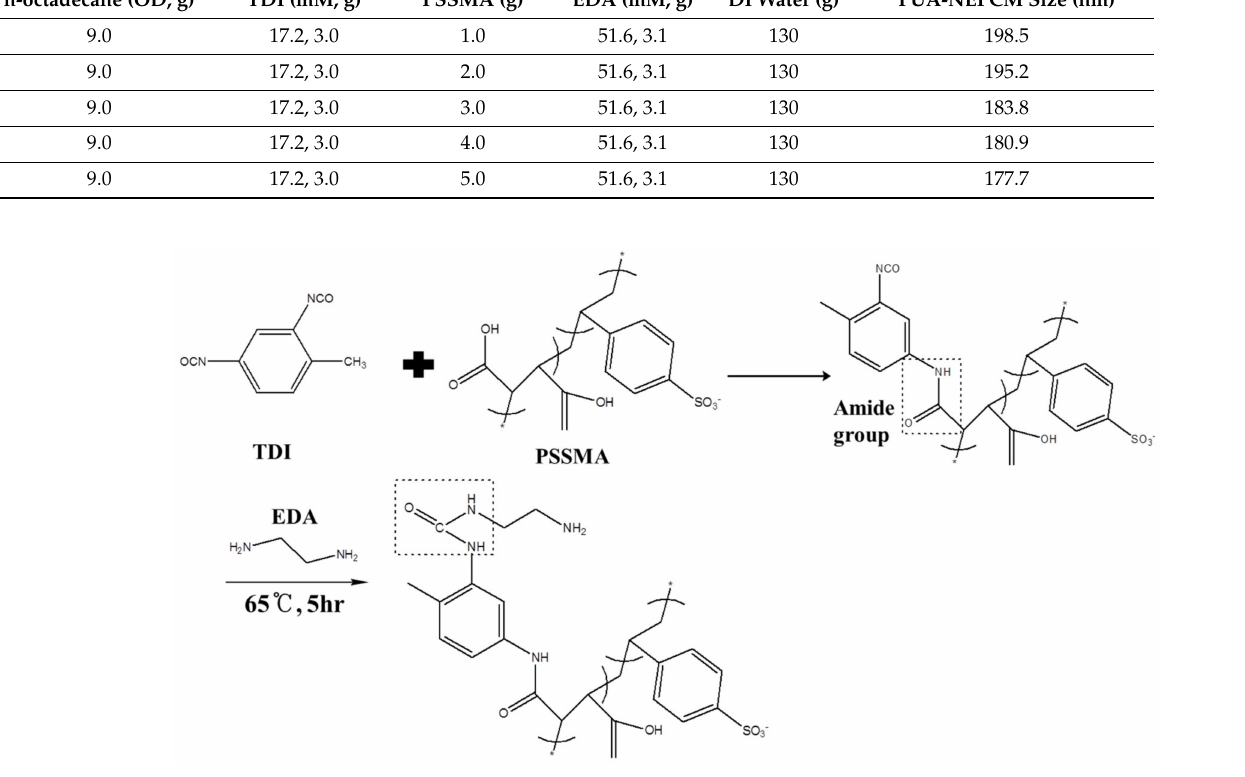
Table 1. Compositions used for the preparation of PUA-NEPCMs. Experimental n-octadecane (OD, g)